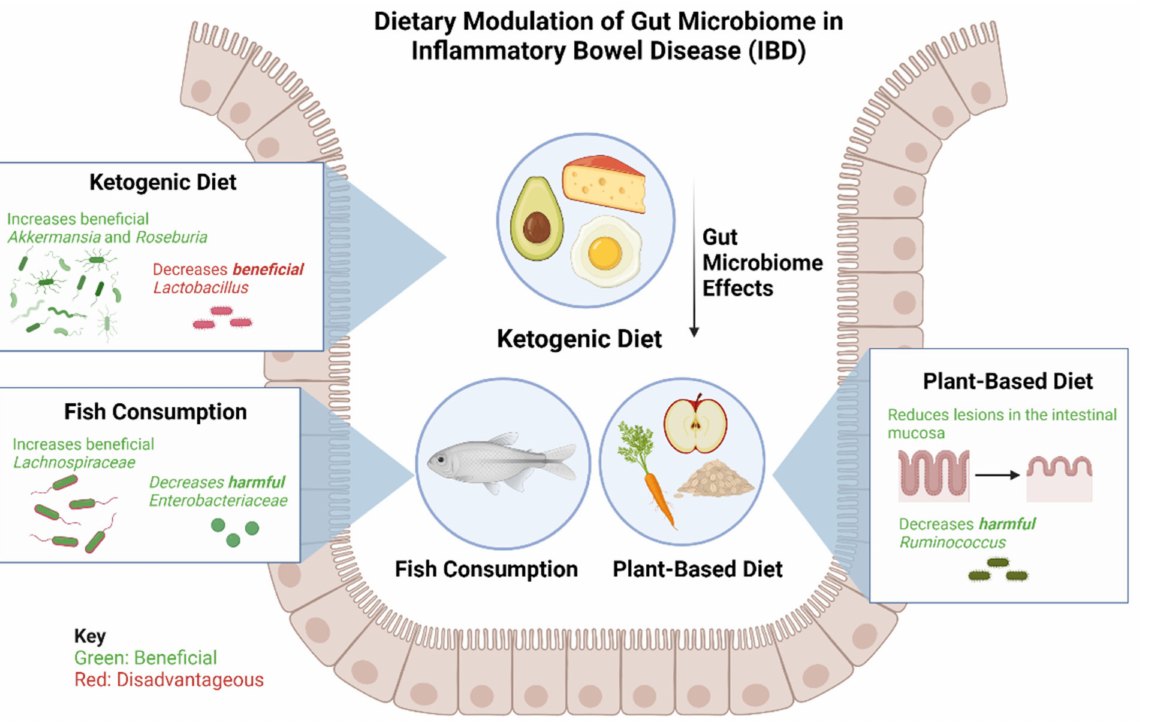
Figure 2. Effects of a ketogenic diet, plant-based diet, and fish consumption on gut microbiome in patients with IBD. The ketogenic diet has been shown to increase beneficial bacteria Akkermansia and Roseburia and consequently decrease beneficial Lactobacillus . The plant-based diet has been found to be beneficial in reducing lesions of the intestinal mucosa and reducing harmful Ruminococ- cus . Fish consumption leads to an increase in beneficial Lachnospiraceae and a decrease in harmful Enterobacteriaceae